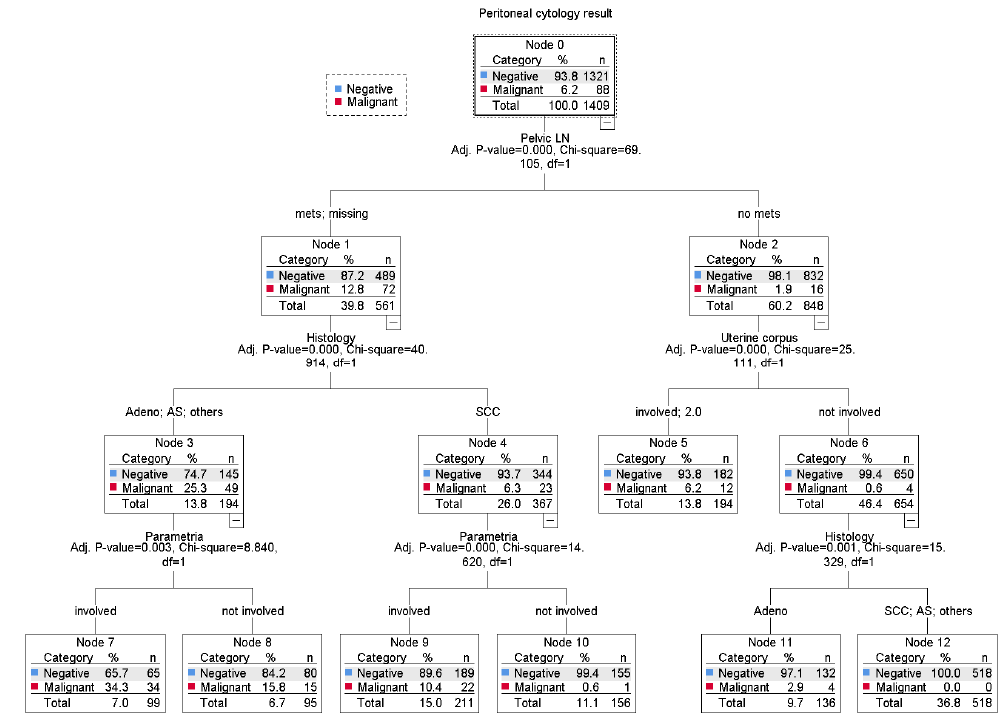
Figure 3. A regression-tree model for the malignant peritoneal cytology. Abbreviations: SCC, squamous cell carcinoma; Adeno, adenocarcinoma; and AS, adenosquamous.